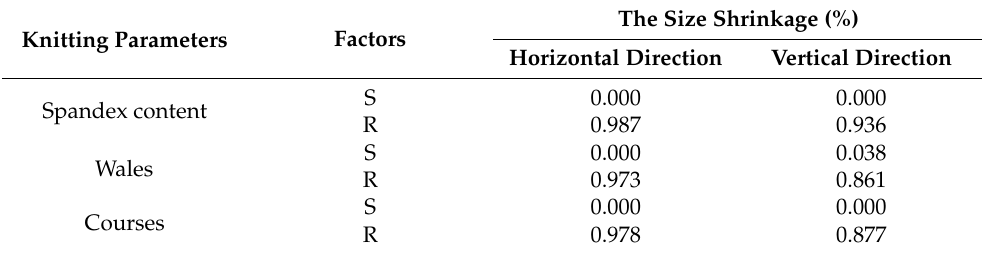
The Size Shrinkage (%) Horizontal Direction Vertical Direction